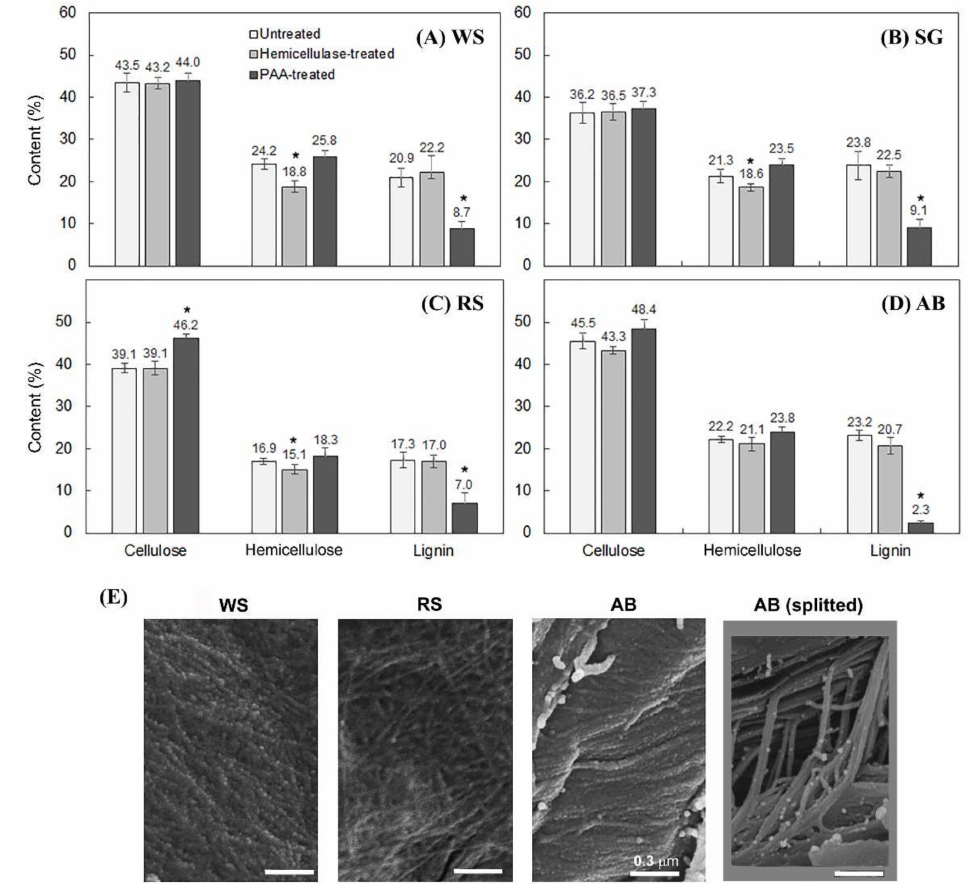
Figure 4. Compositional analysis and FESEM imaging of plant cell walls. Compositional analysis was performed with cell wall samples of ( A ) wheat straw (WS), ( B ) switchgrass straw (SG), ( C ) rapeseed straw (RS), and ( D ) apple tree branch (AB) before or after pretreatment by hemicellulases or PAA. Data are the means of three biological replicates and error bars show the standard deviation. Asterisks indicate the significant difference (determined by t -test) between hemicellulase-pretreated or PAA- pretreated and untreated crop residue biomass (* p < 0.01). ( E ) FESEM images were obtained after PAA pretreatment to expose fibrillar cellulose on cell wall surfaces. Scale bar, 0.3 µ